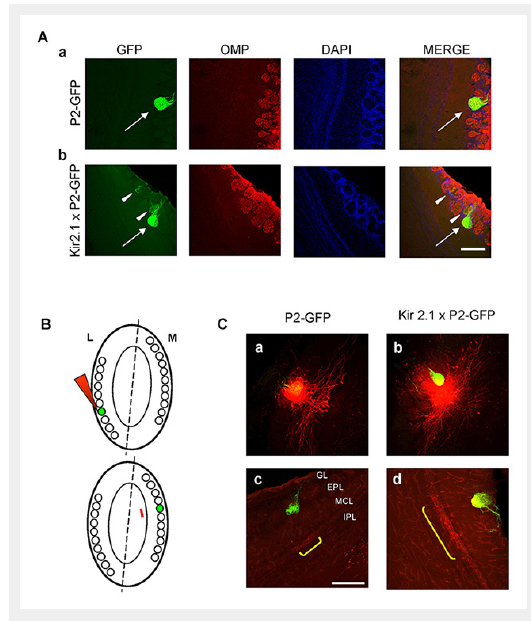
Neuronal wiring in the olfactory bulb of Kir2.1 mice. A. Organisation of glomeruli in control and Kir2.1 mice. Organisation of P2 glomeruli was revealed by immunolabelling horizontal sections of the olfactory bulb (OB) with antibodies against olfactory marker protein (OMP, in red). GFP expressed in P2 axons (green). Nuclei stained by the nuclear marker, DAPI (blue). Aa, Ab, P2-axons coalesce to form glomeruli formed by fibres expressing OMP and GFP, i.e. bearing P2 receptor, in P2-GFP and in Kir2.1 X P2-GFP mice (arrows). Ab, P2-axons innervate also additional adjacent glomeruli formed by fibres expressing GFP and OMP, but also only OMP (i.e. expressing a different receptor than P2, arrowheads) in Kir2.1 X P2-GFP mice. B. Schematic of the experimental procedure. The dashed line indicates line of symmetry between glomerular maps, within each olfactory bulb. Homologous glomeruli are indicated by green labels. The red arrowhead indicates the tracer injection targeted to the lateral glomerulus (top). The red line refers to external tufted cell (ETC) projection just underneath the medial homologous glomerulus on the opposite side of the OB (bottom). C. Intrabulbar circuitry in control and Kir2.1 mice. Examples of focal tracer injections (red spots) targeted to the medial P2-GFP glomerulus in control (a) and Kir2.1 mice (b). ETC axons labelled in (a) and (b) give rise to anterograde projections (yellow brackets) underneath the homologous P2-GFP glomeruli on the opposite side of the olfactory bulb in control (c) and Kir2.1 (d) mice. In Kir2.1